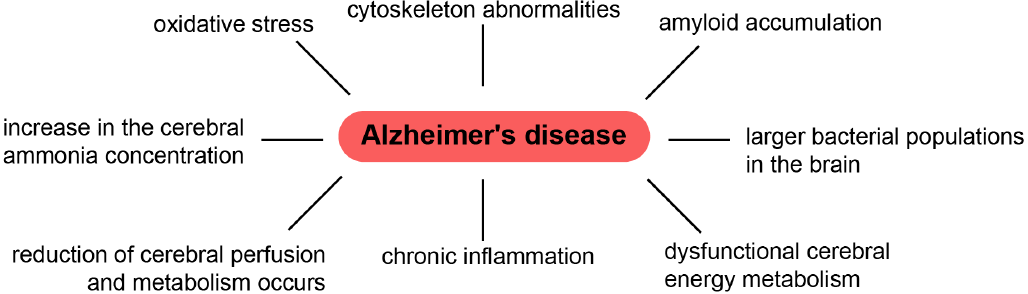
Figure 1. The mechanisms of AD.